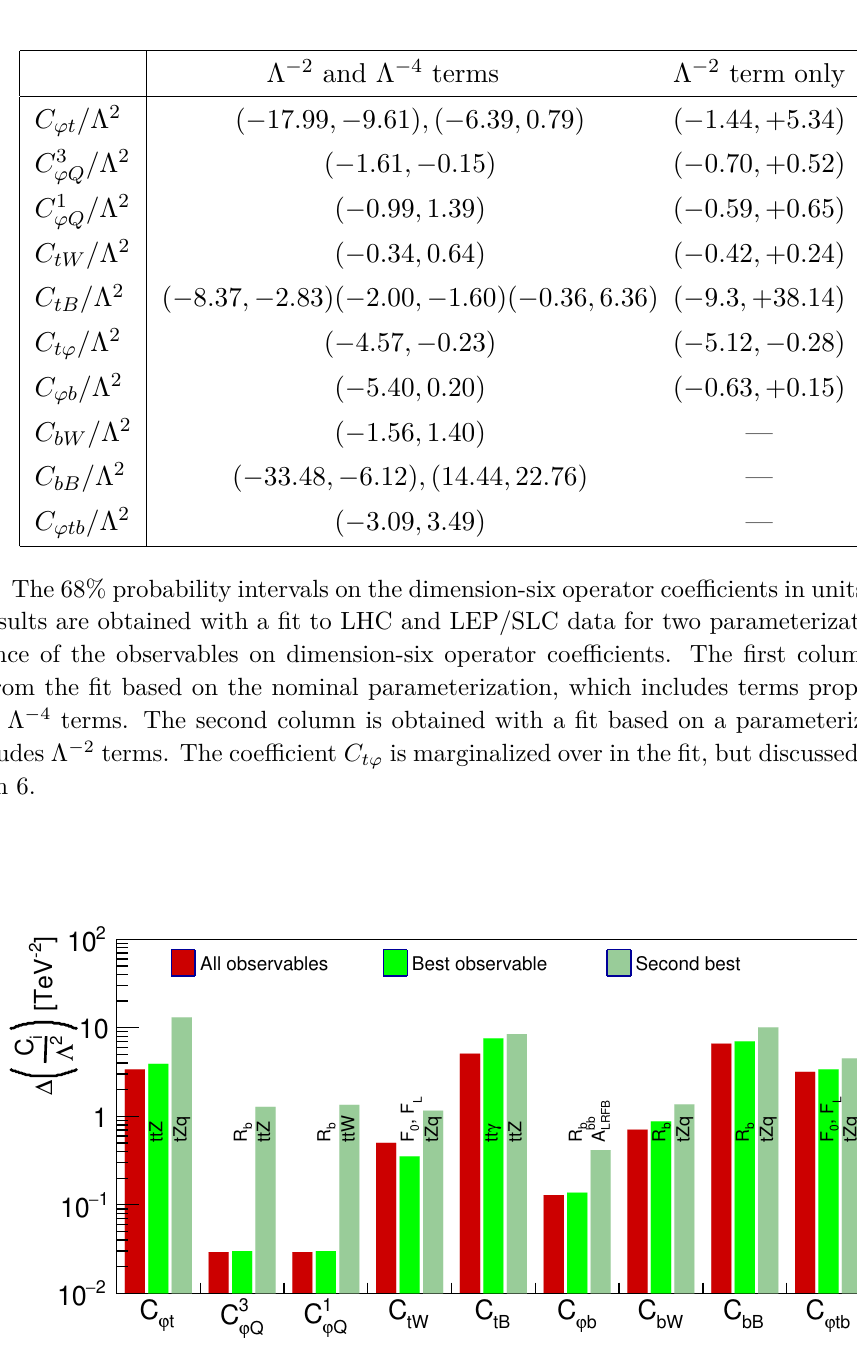
Figure 1 . Corrected results of single-parameter individual fits to the Wilson coefficients of the dimension-six operators introduced in section 2. For each operator the 1 σ uncertainty is shown. The three bars respectively correspond to the result of the combined fit using all data (red), to the constraint obtained from the most sensitive single measurement (light green), and to that of the second-best measurement (greyish green).